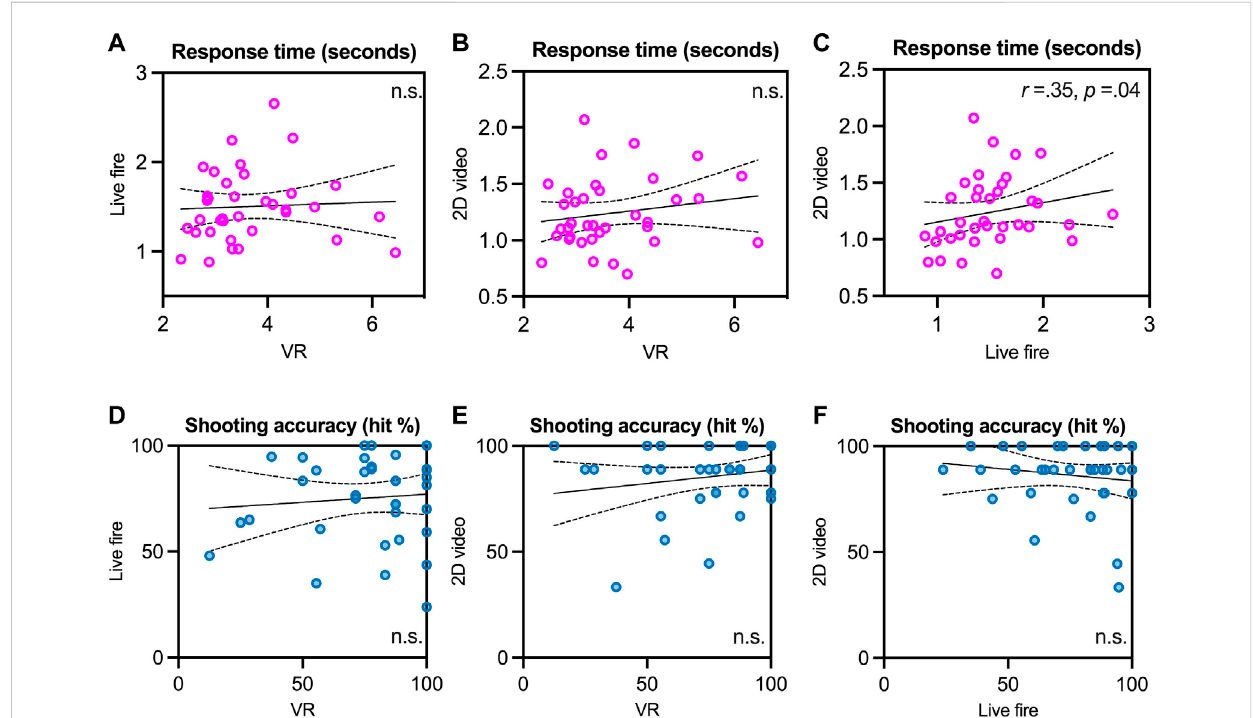
FIGURE 4 Scatter plots of concurrent validity correlations for response time (A – C) and shooting accuracy variables (D – F) . The solid line represents the fi tted regression line and dotted lines indicate 95% con fi dence interval of the line (n.s. = non-signi fi cant). Note in panels (A – C) , different axis limits are used for VR, live fi re, and 2D video due to the large differences in response times across the